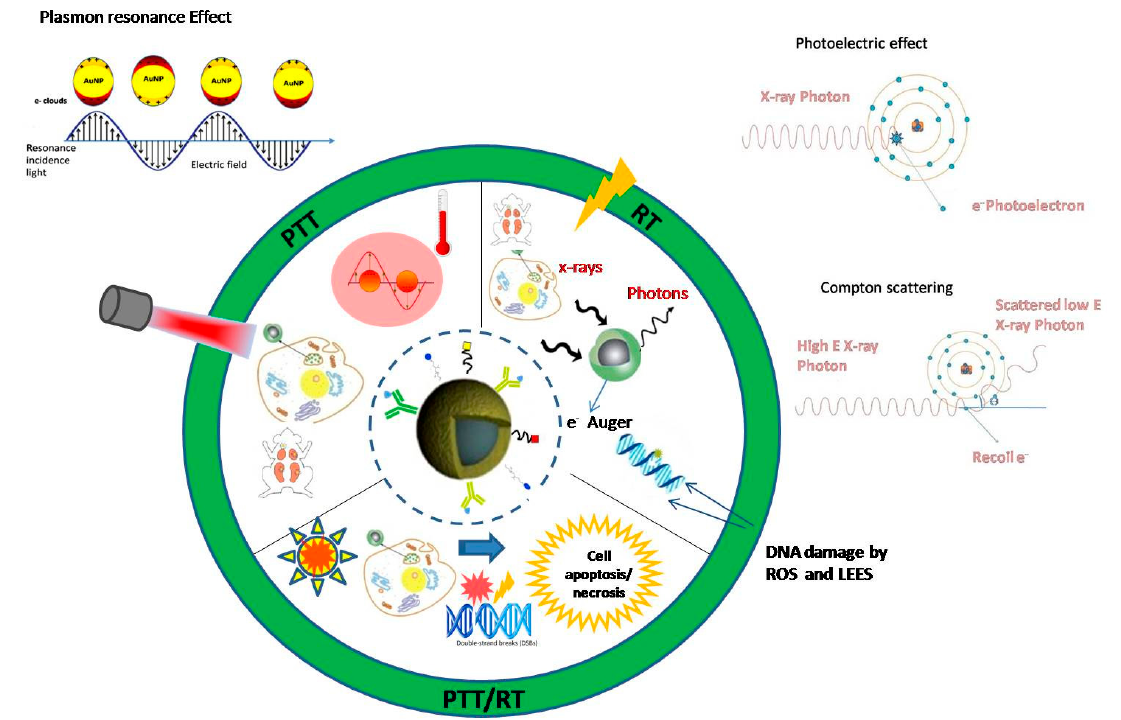
Figure 1. A schematic representation of the basic action mechanisms of photothermal therapy (PTT), ionizing RT and combined PTT/RT in cancer treatment based on functionalized AuNPs.